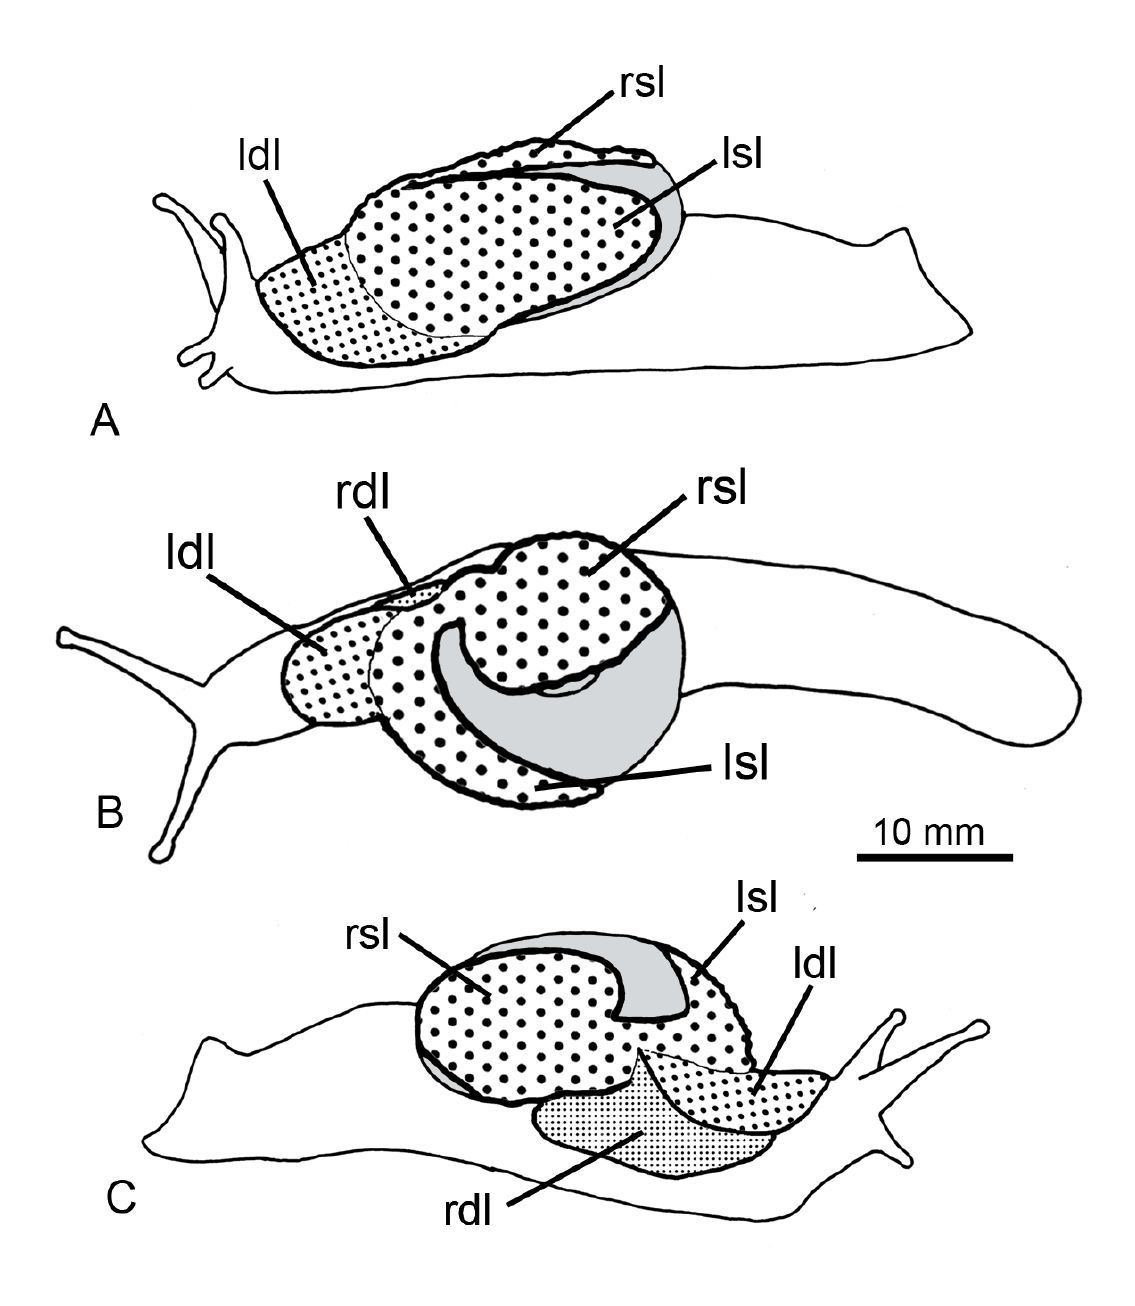
Fig. 7. Arrangement of the mantle in Varadia amboliensis Bhosale, Thackeray, Muley & Raheem gen. et sp. nov. A. Left lateral view. B. Dorsal view. C. Right lateral view. The shell is shaded in grey. Abbreviations: ldl = left dorsal lobe; rdl = right dorsal lobe; lsl = left shell lobe; rsl = right shell